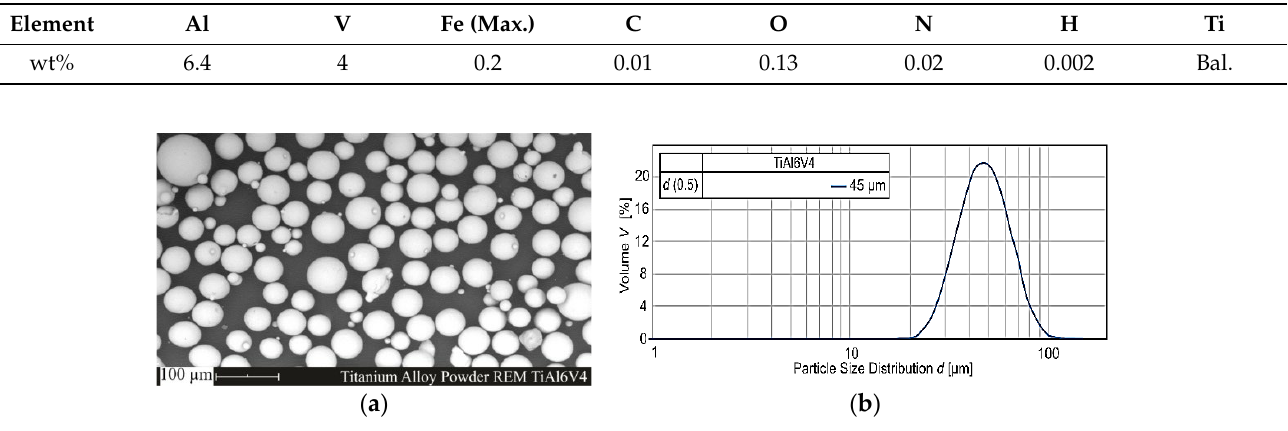
Figure 1. The shape and morphology of the starting powder: ( a ) SEM micrograph of the Ti6Al4V powder, and ( b ) the particle size distribution.